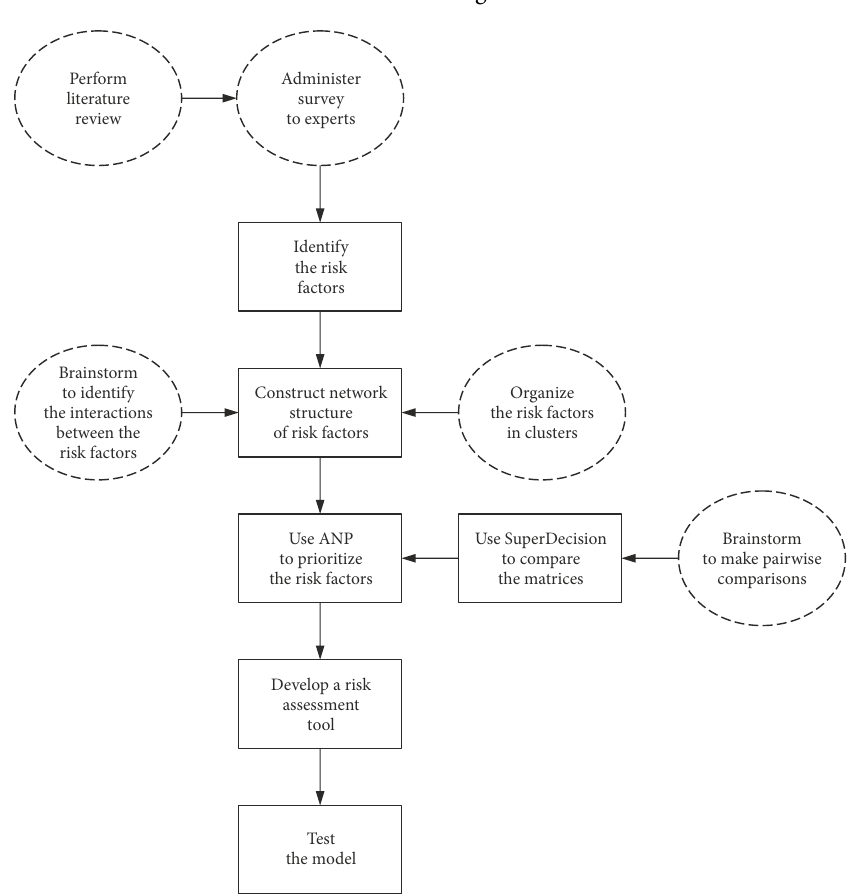
Figure 1. Proposed ANP-based risk assessment model for PPP hydropower investments